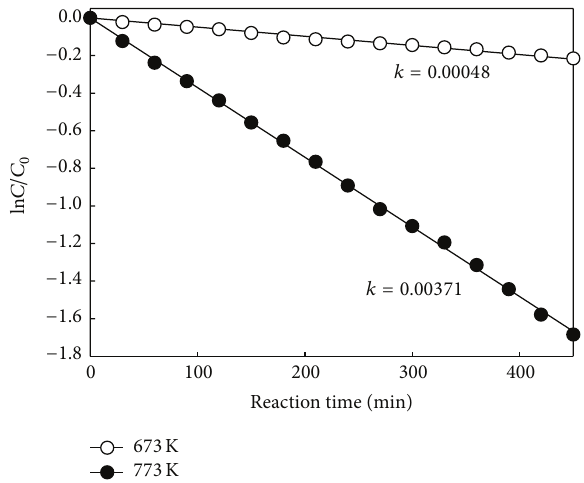
Figure 7: Photocatalytic decomposition of BTB on the CVD grown TiO 2 film with different deposition